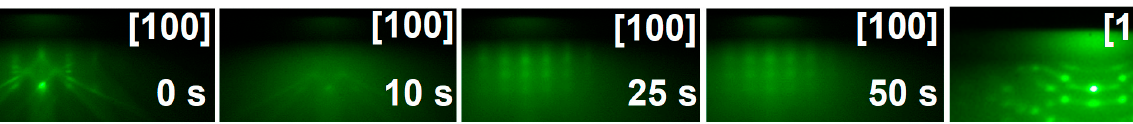
Figure 2. Representative RHEED patterns observed during very early stage of the growth of (100) BST-0.5 thin film on single crystal (100) MgO SrTiO 3 as a function of time in seconds, and therefore, increasing film thickness. Note, the very sharp substrate pattern (at t = 0 s) quickly turns into spots (t = 25 s and 50 s) along the [100] azimuth. A pattern along the [110] azimuth at 10,000 s is in the extreme right panel.